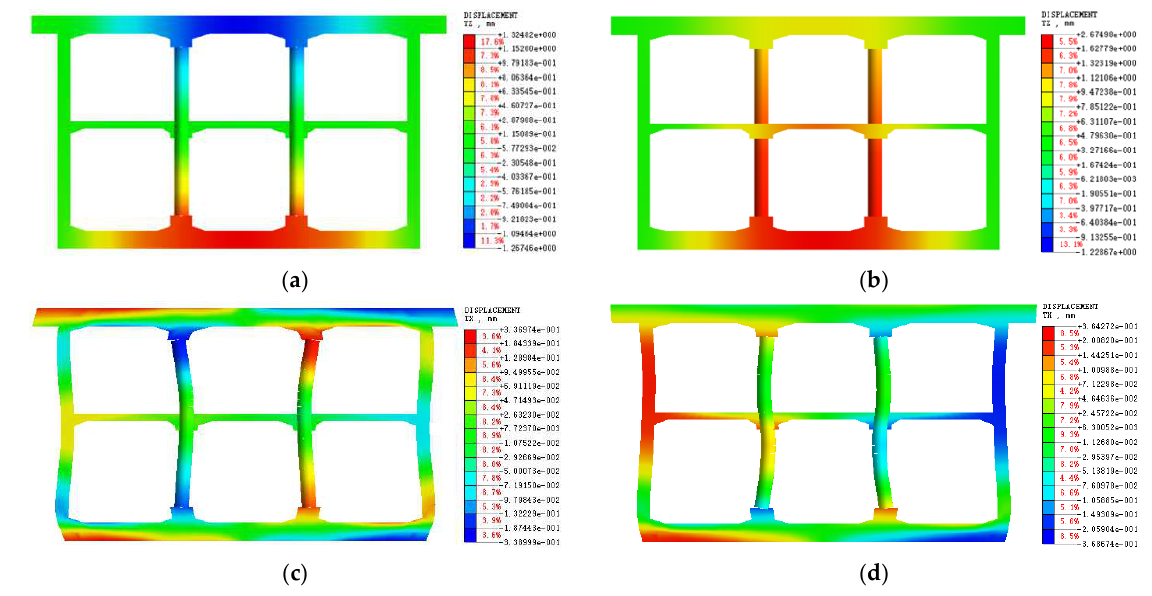
Figure 6. Displacement cloud diagram of section A-A of existing station before and after excavation. ( a ) Vertical displacement before excavation; ( b ) vertical displacement after excavation; ( c ) horizontal displacement before excavation (enlarged by five times); ( d ) horizontal displacement after excavation (enlarged by five times).